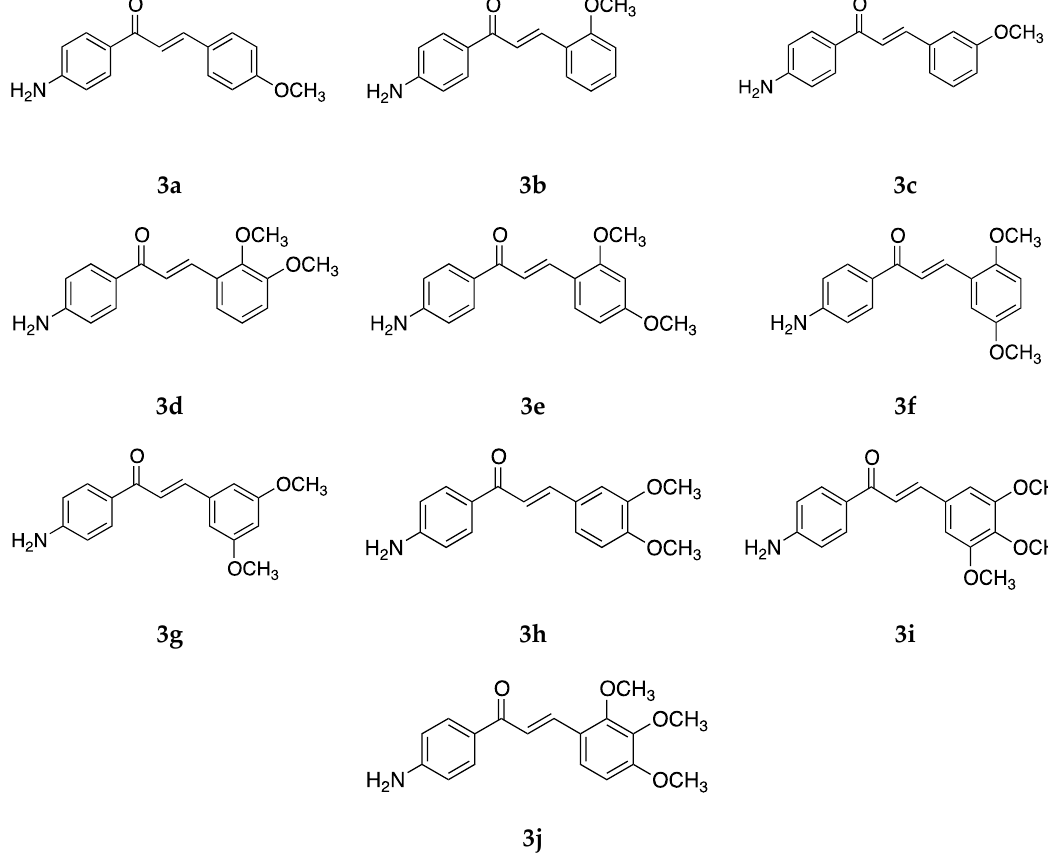
Figure 5. Chemical structures of 4-aminochalcone derivatives with methoxy substitutions on ring B. Table 3. Inhibitory e ff ect of compound 2 against human Molt 4 / C8, CEM T-lymphocytes, murine P388, and